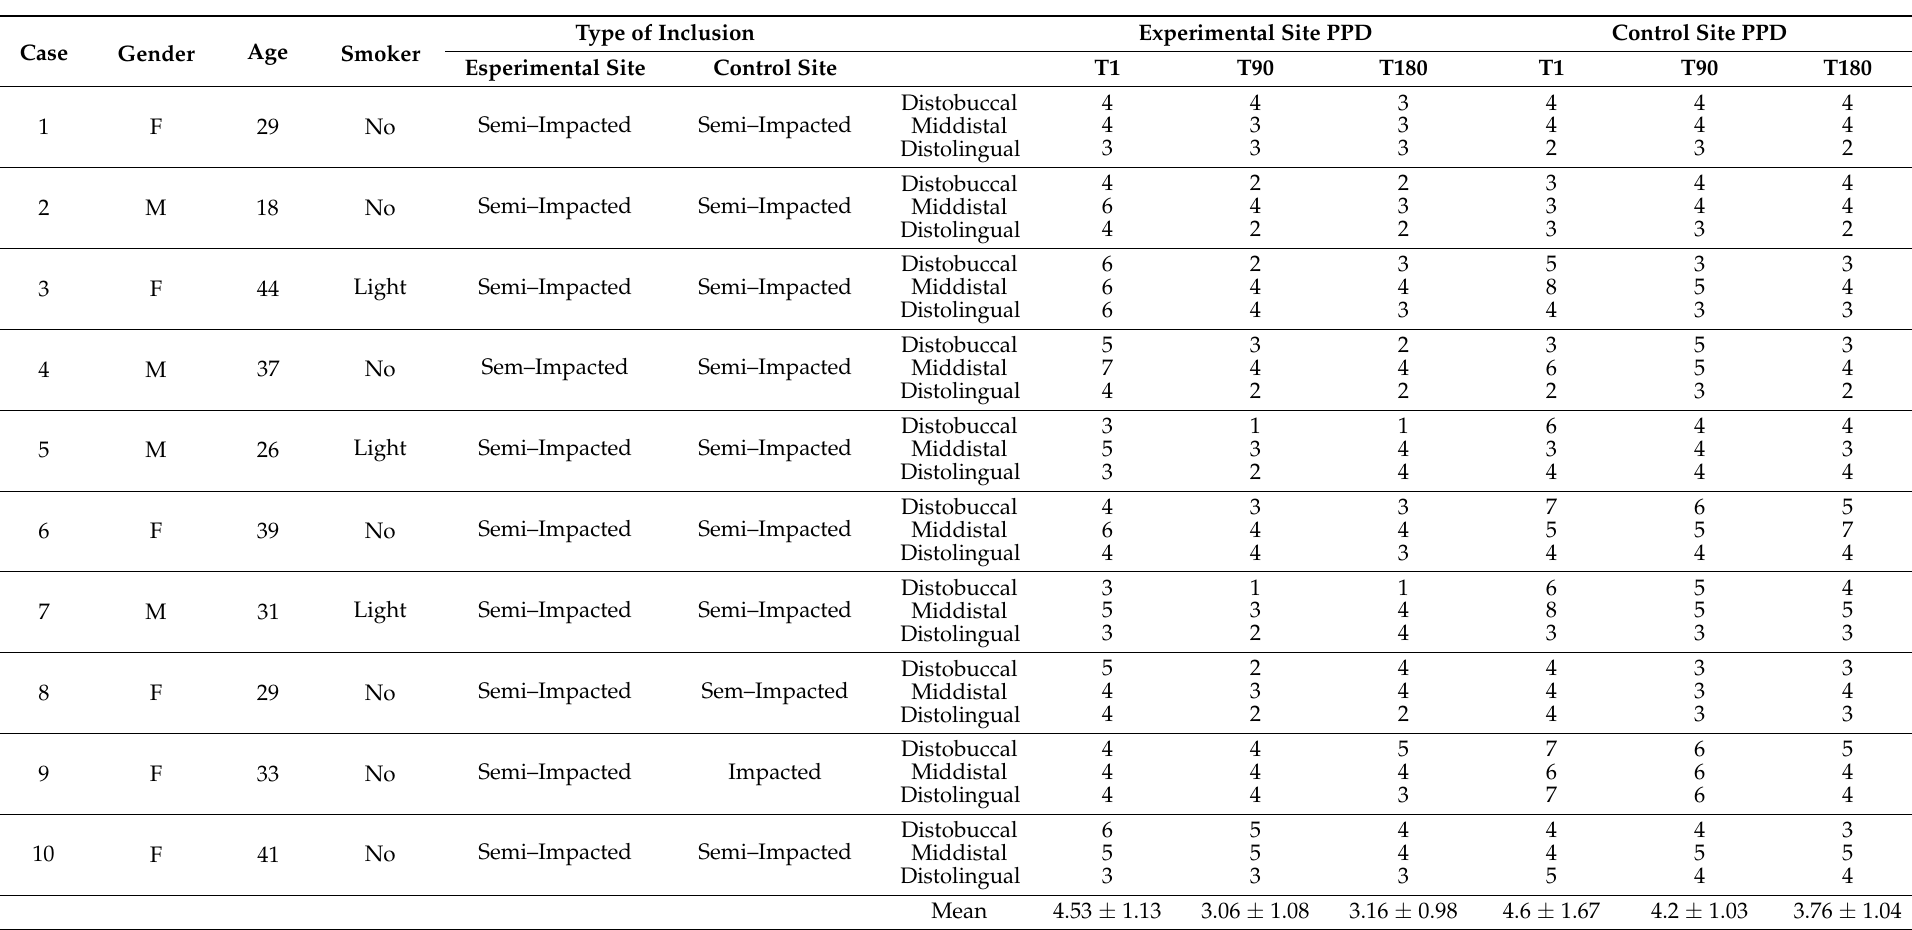
Table 1. Patient’s characteristics: gender, age, light-smoker (<10 cigarettes/day) or nonsmoker, type of inclusion; probing pocket depth (PPD, mm) of the distal aspect of the experimental site and the control site at different follow-up intervals; mean values of PPD. PPDs > 3 mm are reported in